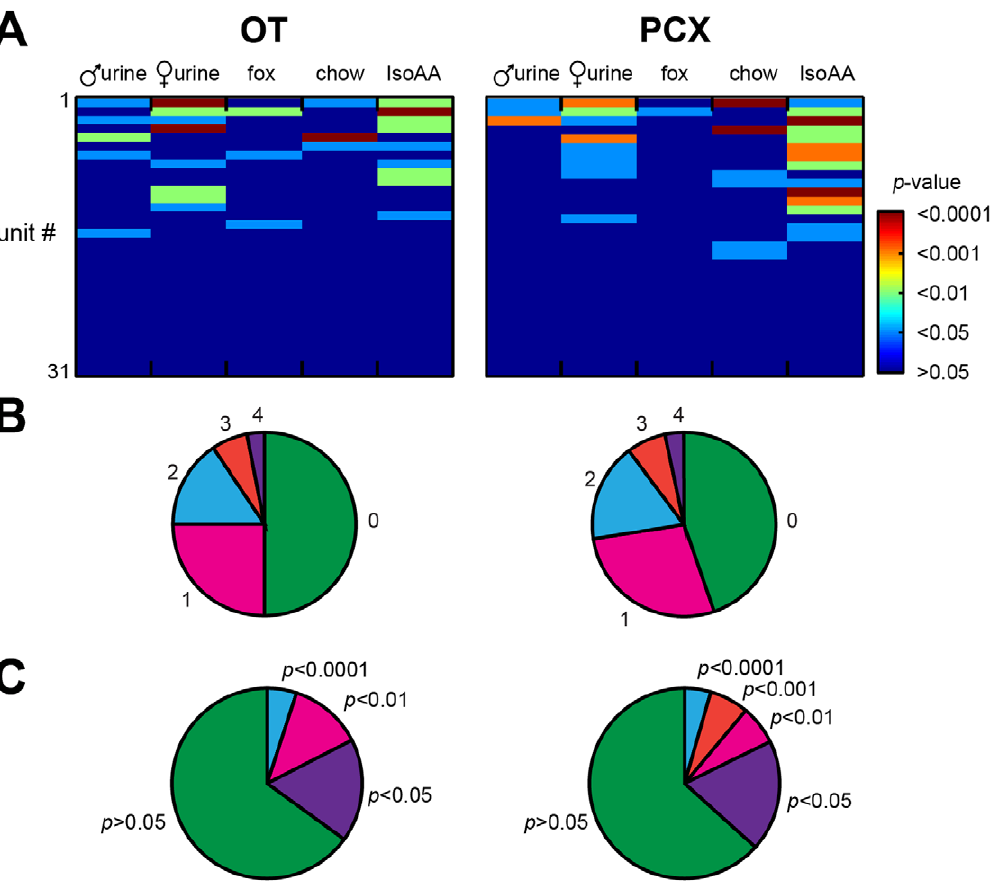
Figure 4. Odor-evoked response probability in the OT and PCX. ( A ) 3-dimensional histogram of odor selectivity among OT (left) and PCX units (right) in response to the five odorants (male mouse urine, female mouse urine, fox urine, chow, IsoAA; see Materials and Methods). p value=2- tailed t -test of spiking 2 sec pre-odor vs. 2 sec during odor ( $ 4 trials/odor/unit). Units arrangement ( # 1,2,3, etc.) is based upon average magnitude of significance across odors. Whereas some odors evoked significant responses throughout numerous units (e.g., IsoAA), others (e.g., fox urine) did not. ( B ) Pie charts of unit tuning in OT and PCX. 0=not responsive to any odor, 4=responsive to 4 odors (no unit responded to all 5 odors). 50% of OT and 58% of PCX units displayed a significant modulation in firing rate to at least one odor. Same data as in (A). ( C ) Pie charts of response magnitudes of odor-evoked activity in OT and PCX. Same data as in (A).